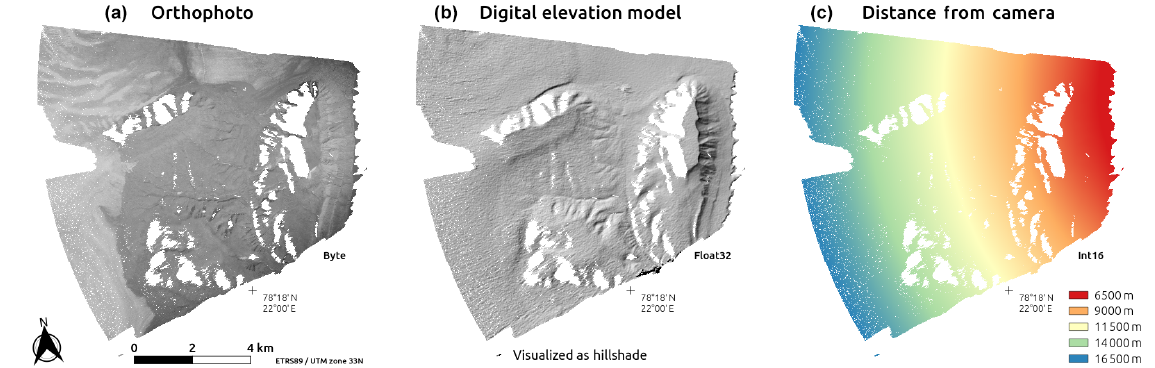
Figure 6. Rasters extracted from a single point cloud. (a) Orthoimage. (b) Hillshade of the DEM. (c) Distance to the camera.